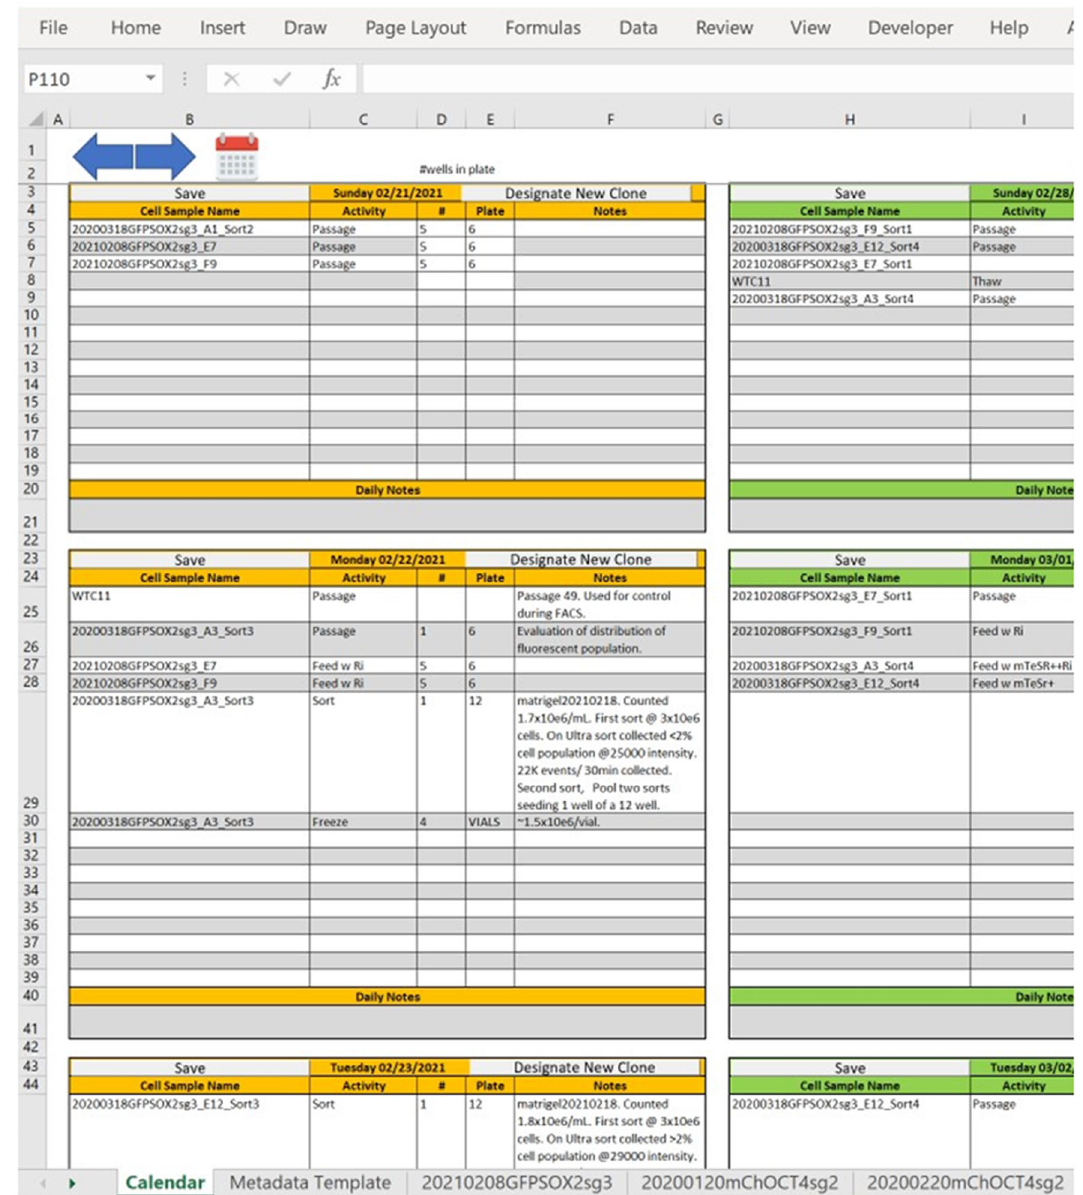
Figure 4. The Calendar worksheet. This is a partial view of the worksheet for capturing daily experimental and maintenance activities. The user can navigate to any date, choose entries from drop-down lists, and add free text